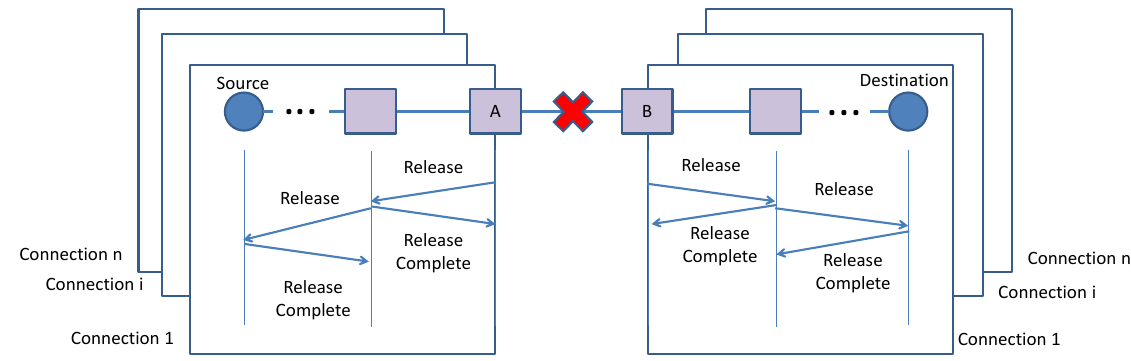
Figure 14. Releasing the allocated communication resources after edge